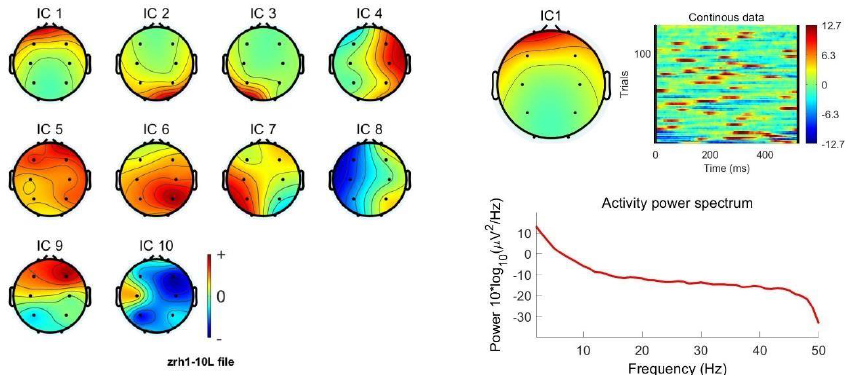
Figure 2. ( a ) The waveform of the EEG segment in the marked time interval is significantly different from the normal EEG signal outside the interval, which is an obvious bad segment. ( b ) EEG waveform with bad segments removed.